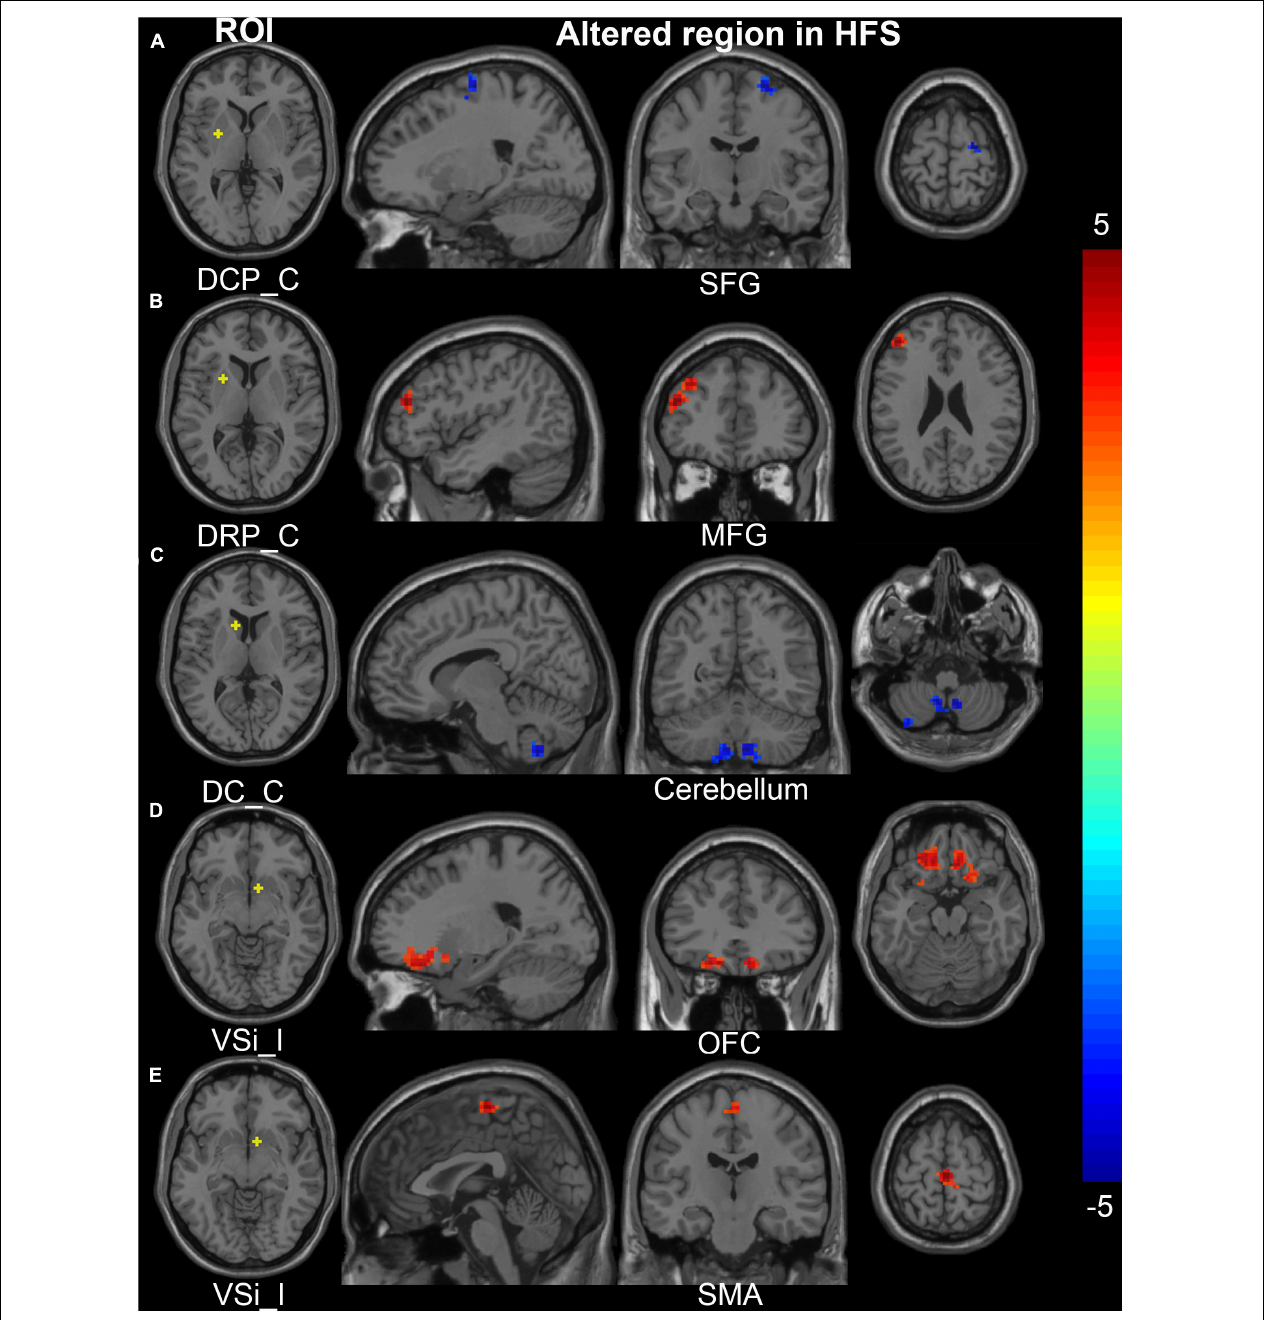
FIGURE 3 | Altered FC in the cortical-striatal network (putamen, caudate, and inferior ventral striatum ROIs). In the HFS group compared with the HC group: (A) The FC between contralateral DCP and ipsilateral SFG was decreased. (B) The FC between contralateral DRP and contralateral MFG was increased. (C) The FC between contralateral DC and bilateral cerebellum was decreased. (D) and (E) The ipsilateral VSi showed increased FC with bilateral OFC and SMA. The color bar represents the t value. FC, functional connectivity; ROIs, regions of interest; HFS, hemifacial spasm; HC, healthy control; C, contralateral; I, ipsilateral; DCP, dorsal caudal putamen; DRP, dorsal rostral putamen; DC, dorsal caudate; VSi, inferior ventral striatum; SFG, superior frontal gyrus; MFG, middle frontal gyrus; OFC, orbitofrontal cortex; SMG, supramarginal gyrus; SMA, supplementary motor area.